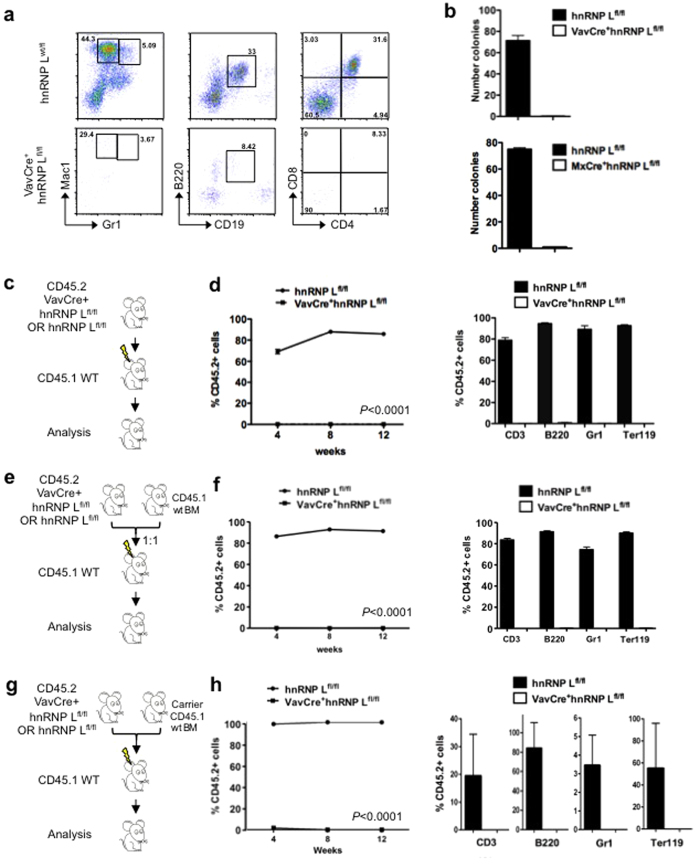
HSCs require hnRNP L to be functional.(a) Differentiation assays on OP9 and OP9-DL1 stromal cells; representative dot plots of myeloid cells (Gr1+Mac1+), B-cells (B220+CD19+) and T-cells (CD4+CD8+) differentiation of FL LSK cells from control (upper panel) and VavCre+hnRNP Lfl/fl mice (lower panel) (n = 3) (b) Colony assay on methylcellulose; 500 LSK cells from FL or BM from the indicated mice were seeded on methylcellulose and colonies were counted after 10 days of culture (n = 3). (c) Non-competitive transplantation assay: 2 × 105 FL cells of either VavCre+hnRNP Lfl/fl or control (hnRNP Lfl/fl) stage E14.5 embryos (both CD45.2+) were transplanted into irradiated syngenic CD45.1+ mice and the percentage of total CD45.2+ cells in the blood were measured at 4, 8 and 12 weeks post-transplantation. (d) The frequency of CD45.2+ cells within the T-, B-, myeloid or erythroid subpopulations (i.e. within CD3, B220, Gr1, Ter119 positive cells) in the blood of the recipient mice 12 weeks post-transplantation was assessed (n = 6). (e) Competitive transplantation assay: 2 × 105 FL cells from VavCre+hnRNP Lfl/fl or VavCre+hnRNP Lwt/fl were mixed with 2 × 105 normal CD45.1+ BM cells at a ratio of 1:1 for a total of 4 × 105 cells. The mixtures were transplanted into irradiated CD45.1+ recipient mice and the percentages of CD45.2+ cells in the blood were measured at 4, 8 and 12 weeks post-transplantation. (f) The frequency of CD45.2+ cells within the T-, B-, myeloid or erythroid subpopulations (i.e. within CD3, B220, Gr1, Ter119 positive cells) in the blood of the recipient mice 12 weeks post-transplantation was assessed (n = 3). (g) 7.5 × 104 Lin−cKit+ progenitor cells from VavCre+hnRNP Lfl/fl or VavCre+hnRNP Lwt/fl were mixed with 2 × 105 normal carrier CD45.1+ BM cells. The mixtures were transplanted into irradiated CD45.1+ recipient mice and the percentages of CD45.2+ cells in the blood were measured at 4, 8 and 12 weeks post-transplantation. (h) The frequency of CD45.2+ cells within the T-, B-, myeloid or erythroid subpopulations (i.e. within CD3, B220, Gr1, Ter119 positive cells) in the blood of the recipient mice 12 weeks post-transplantation was assessed (n = 3). All error bars are means ± SEM.